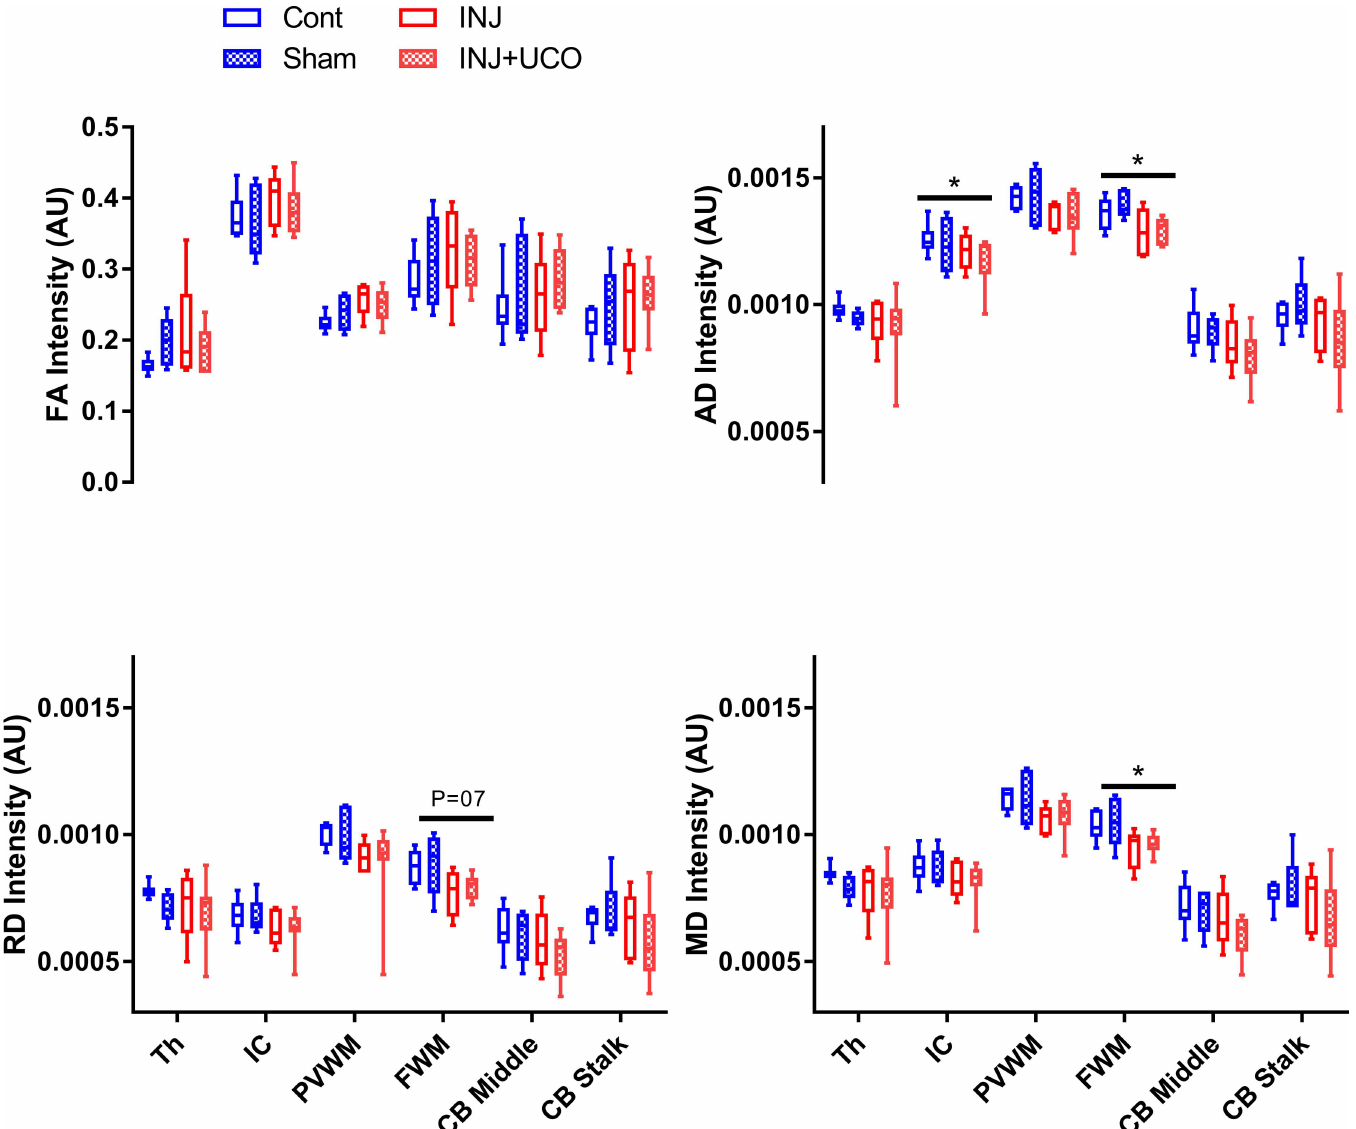
Fig 3. Mean and confidence intervals of DTI measurements for the small regions of interest analyses. Mean fractional anisotropy (FA), axial diffusivity (AD), radial diffusivity (RD), and mean diffusivity (MD) measurements for each regionof interest (ROI) in the unoperatedcontrol (Cont n = 6), sham surgery (Sham n = 5), injuriousventilation (INJ n = 5), and INJ + umbilicalcord occlusion(INJ+UCO n = 7) groups. The ROIs shown in S1 Fig were located in the thalamus(Th), internal capsule(IC), periventricular white matter (PVWM), frontal white matter (FWM), middlecerebellum(CB), and CB stalk. * P < 0.01, ** P < 0.001vs